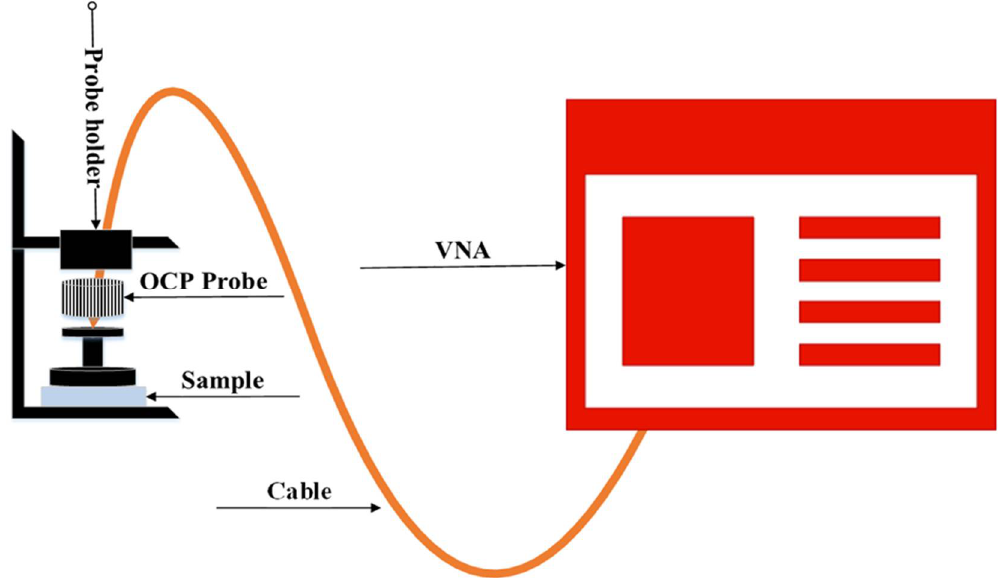
Figure 1. OCP measurement set-up.